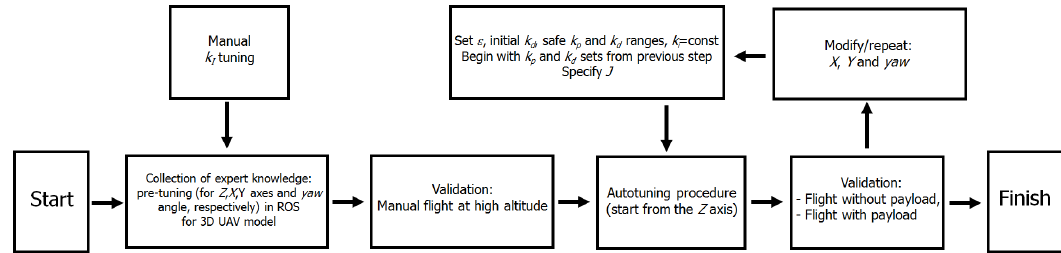
Figure 4. Flowchart for the proposed tuning strategy of the UAV controllers.